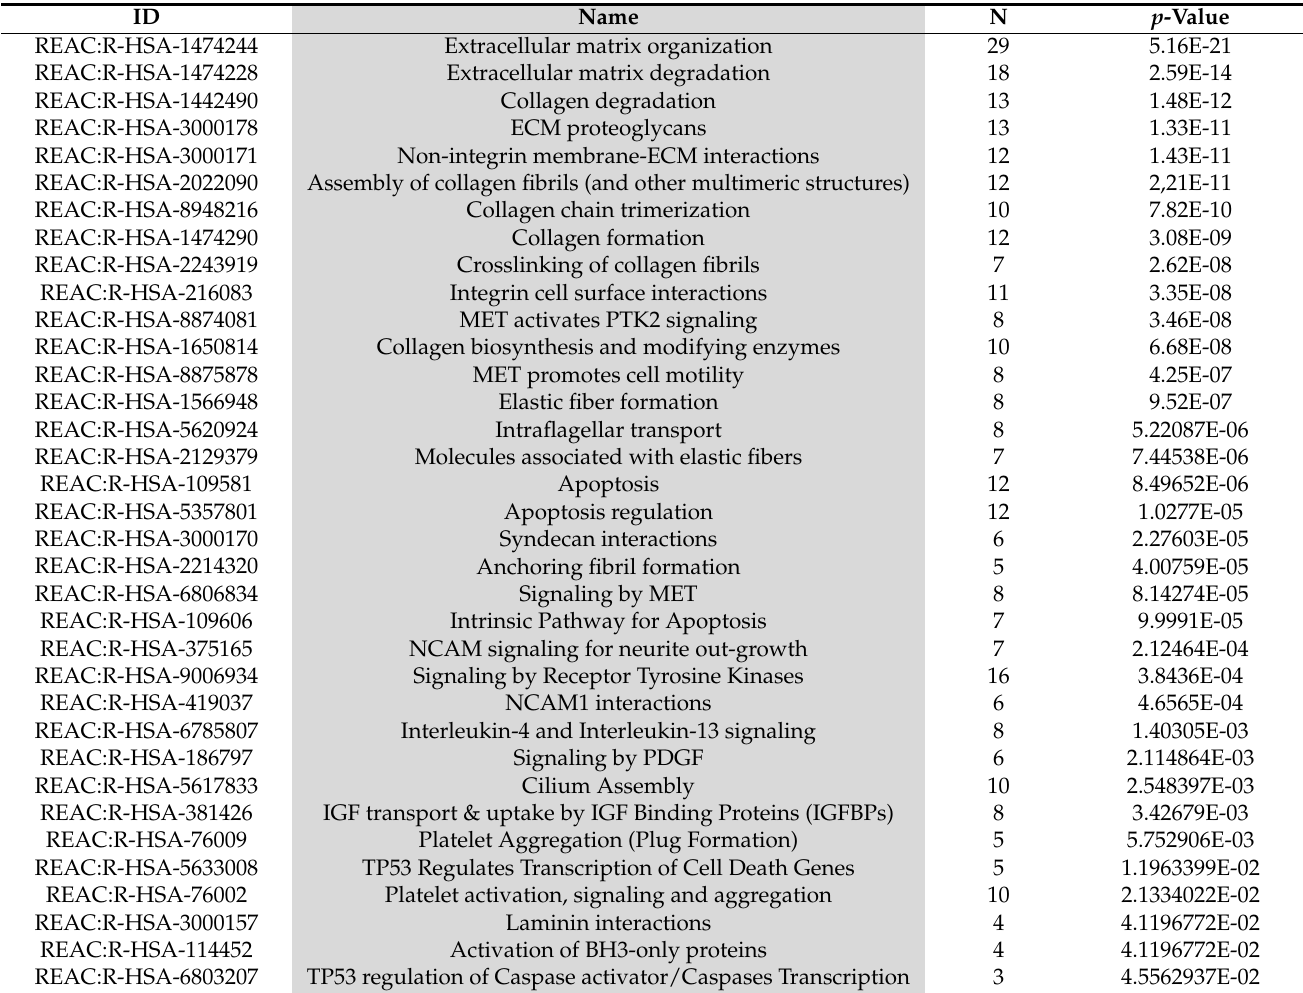
Table 8. Reactomes associated with the 8 tear differentially expressed